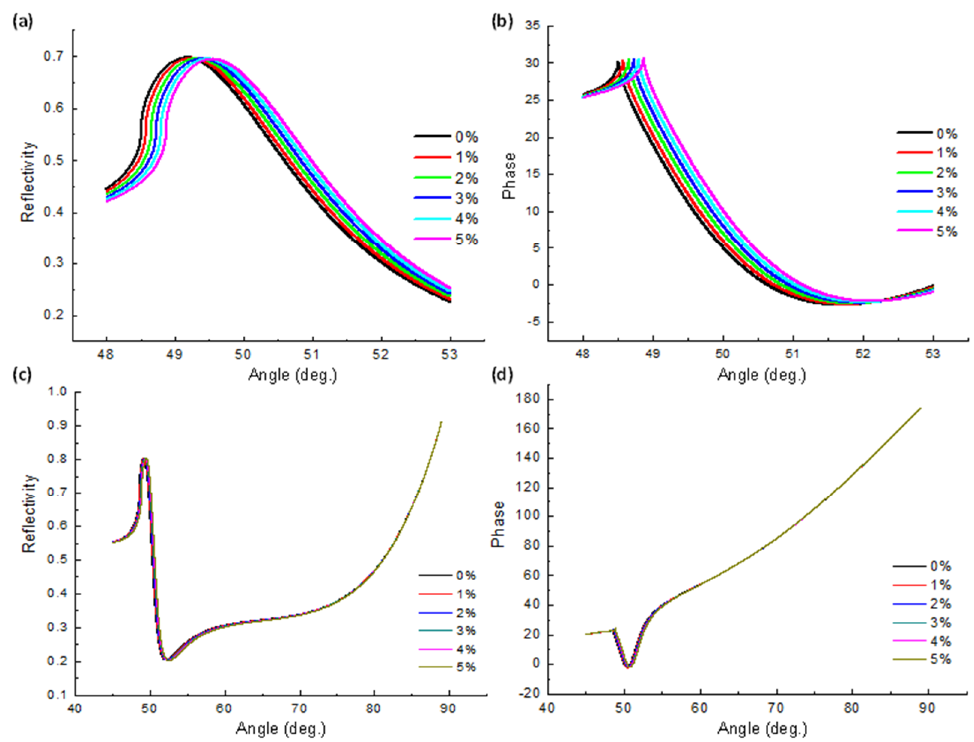
Figure 4. Numerical calculations of ( a , c ) reflectivity and ( b , d ) phase differences with various incident angles of 1150 nm incident light for various concentrations of glucose solution. The thickness of the deposited TiN layer is 46 nm.